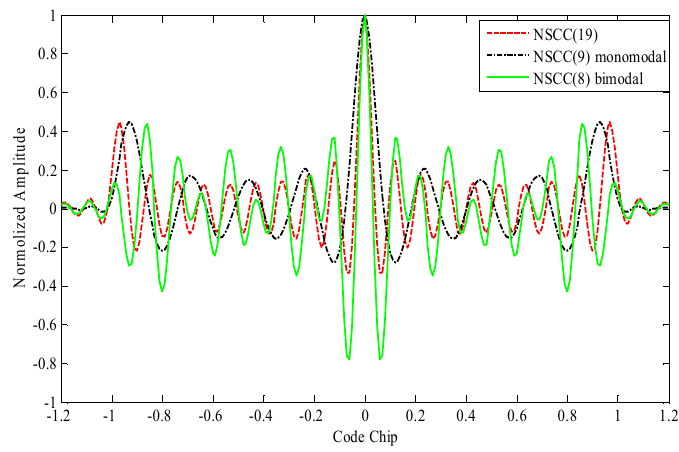
Figure 5. Comparison of ACFs for NSCC baseline structures within 20 MHz.